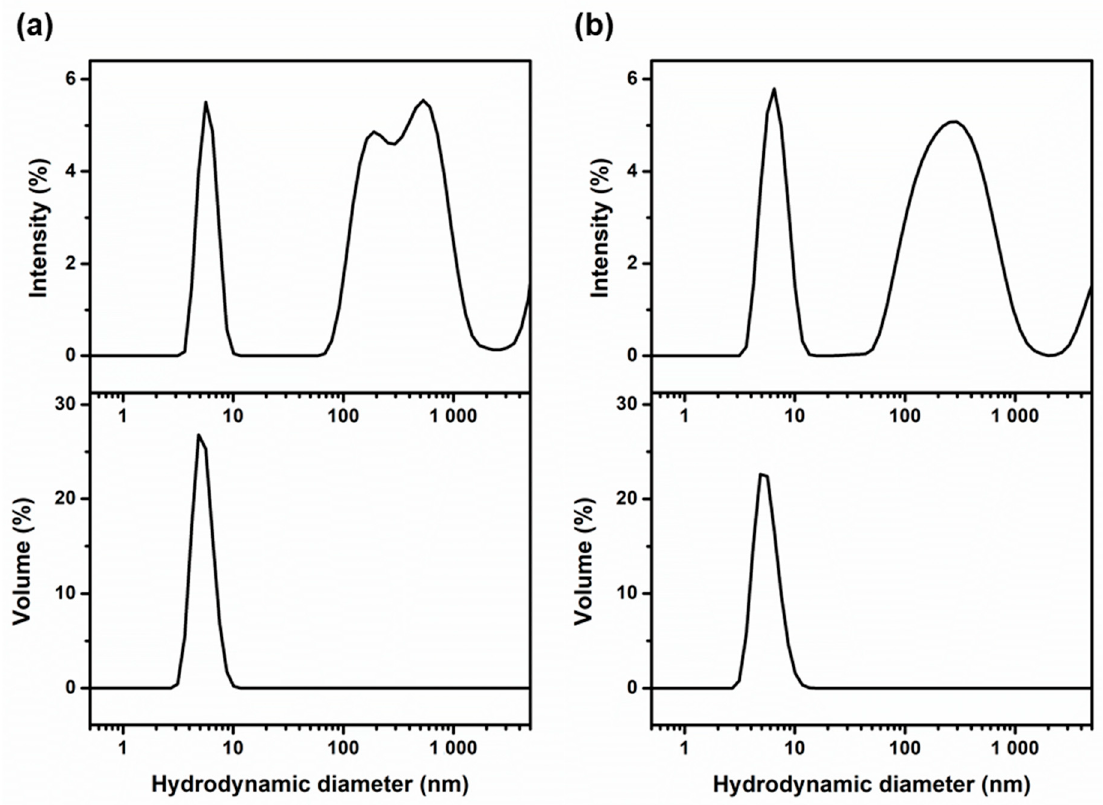
Figure 1. Intensity (above) and volume (below) size distributions of ( a ) pEFS8-26 and ( b ) pEFS8-46 at 25 ◦